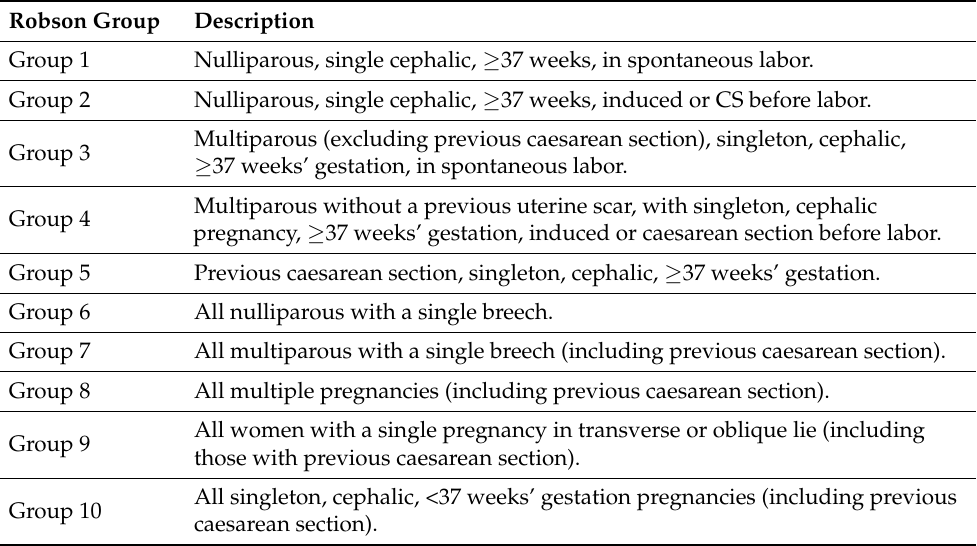
Table 1. The Robson Ten Group Classification System of